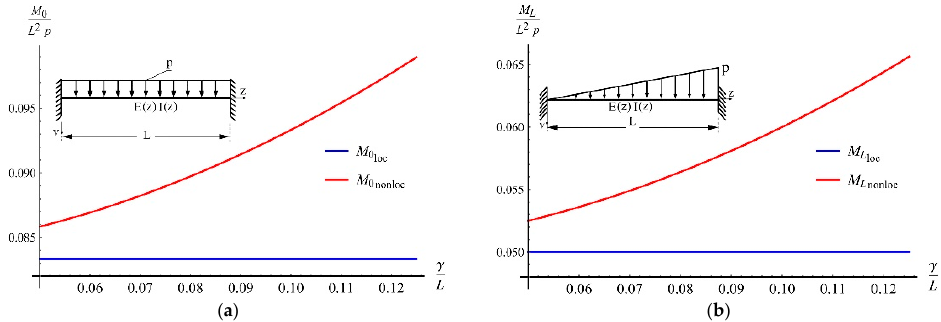
ratio is given in Figure 5b. Figure 5. ( a ) The variation of the initial moment ( ); ( b ) the variation of the end moment ( ). Figure 5. ( a ) The variation of the initial moment ( M 0 ); ( b ) the variation of the end moment ( M L ). 0 M L M (b) Uniform beam with a constant cross section subjected to the triangular load (see Figure 4b). A fixed beam with both ends subjected to the two distributed loads is shown in In this case, Figure 6. In this case, the initial values and end conditions are Figure 6. In this case, the initial values and end conditions are Using Equations (29) and (30), the initial values 0 M and 0 T are found as follows.